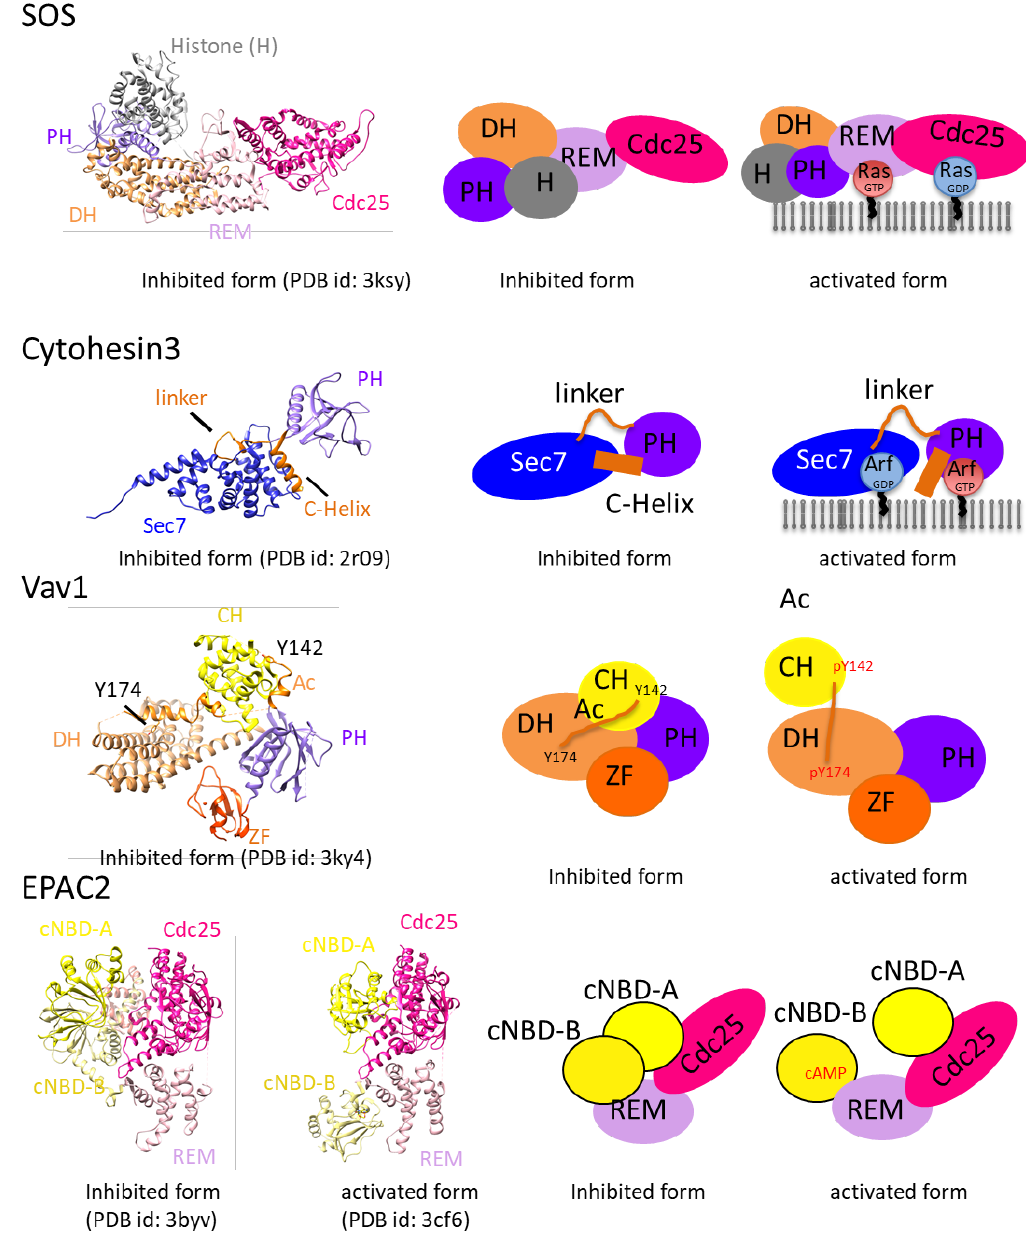
Figure 5. Higher level regulatory mechanisms of GEFs: Positive feedback loops of Rac/RasGEF SOS and Cytohesin3, regulation of Vav1 by the PH-DH module, and regulation of EPAC2 by the second messenger. The right panels show models for each regulatory mechanism.